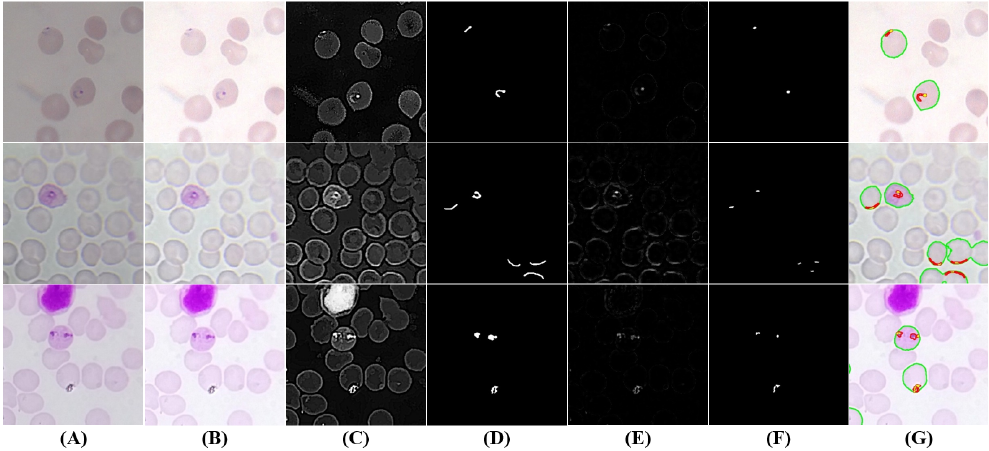
Figure 7. Examples of trophozoites ring stage candidates: ( A ) original image (cropped ROI); ( B ) brightness and contrast enhancement; ( C ) cytoplasm grayscale sharpening; ( D ) cytoplasm segmentation and filtering; ( E ) chromatin grayscale sharpening; ( F ) chromatin segmentation and filtering; ( G ) final candidates (cytoplasm in red; chromatin in yellow; RBC with candidate inside in green).